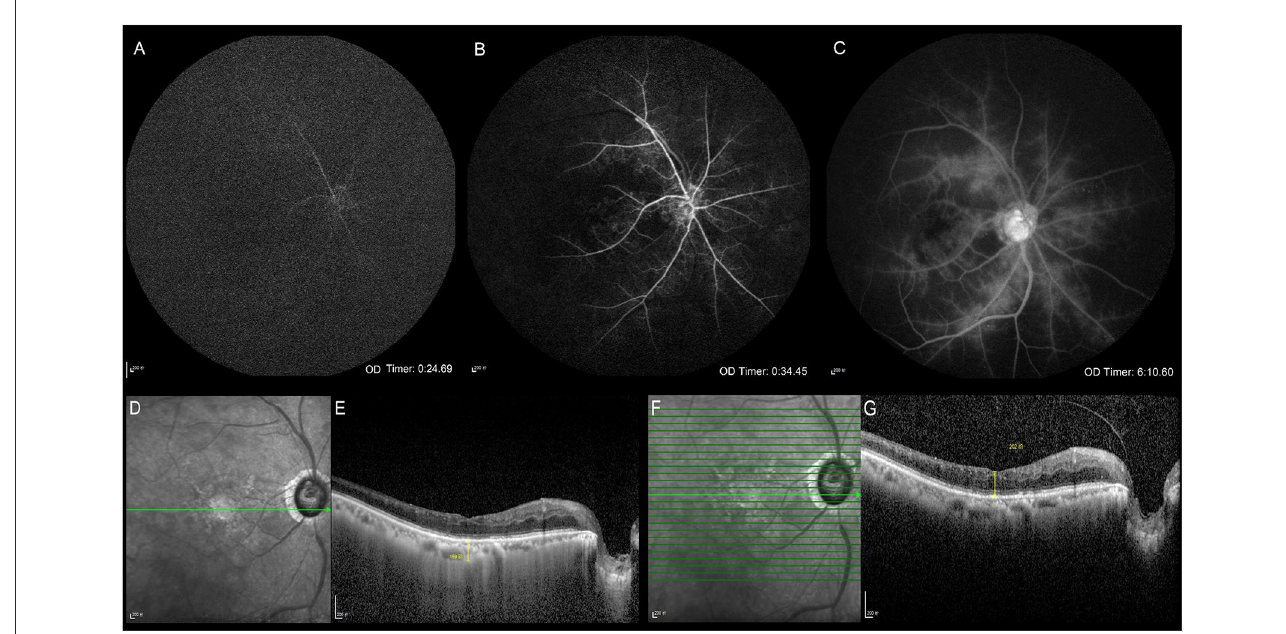
FIGURE1 Clinical ophthalmic examinations. Fundus fluorescein angiography (A–C) . Optical coherence tomography (D–G) . The arm-retinal circulation time is 24.69s showing the delayed retinal arierial filling (A) . The venous phase starts at 34.45s, showing delayed retinal venous filling, which indicates that the